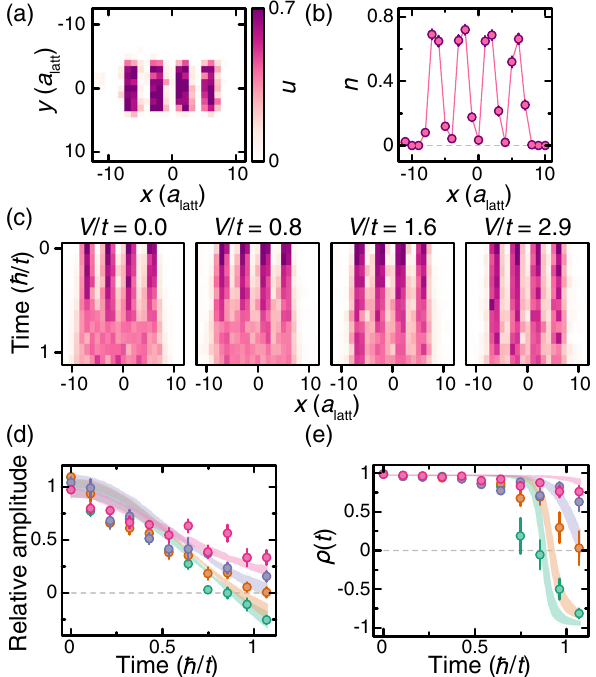
FIG. 4. Interaction dependence of quench dynamics of a charge-density wave. (a) Average initial state density profile for the quench measurements. (b) Density profile averaged along the y direction of the initial state shown in (a). (c) Density profile time evolution for interactions V=t ¼ ½ 0 ; 0 . 78 ð 7 Þ ; 1 . 61 ð 8 Þ ; 2 . 9 ð 2 Þ(cid:2) . Color scale is the same as in (a). (d) Fitted relative amplitude of density profile vs time. Colors (green, orange, purple, and pink) correspond to the interactions in (c) from lowest to highest. (e) Autocorrelation function of the density pattern. Colors are the same as in (d). Shaded curves correspond to numerical simulations. Experimental error bars correspond to the standard error of the